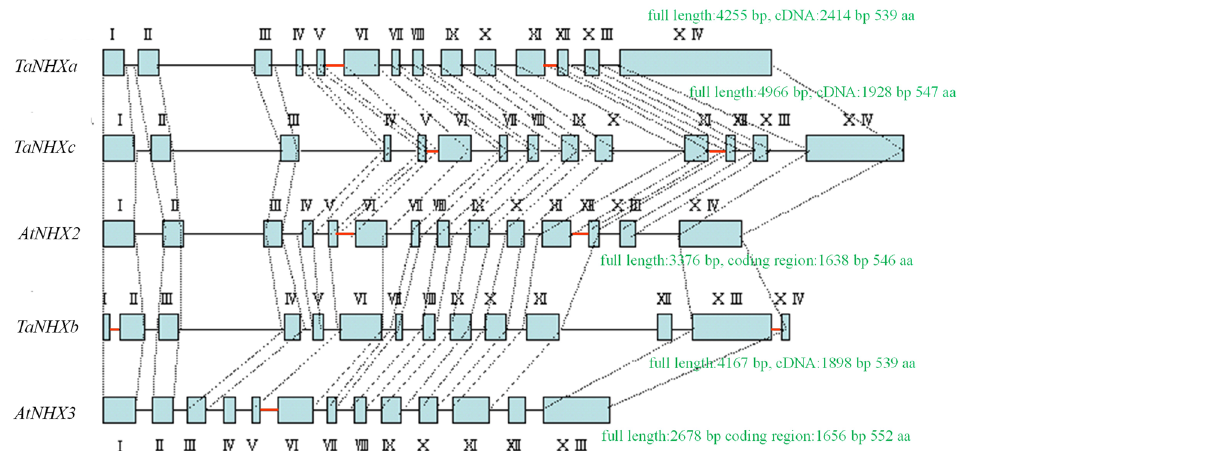
Figure 5 – Structural relationship between the wheat Na + /H + antiporter-like genes and Arabidopsis thaliana antiporter genes. The total DNA structures of TaNHXa , b and c were compared with those of AtNHX2 and 3 of Arabidopsis thaliana . TaNHXa , b and c were 22~55 % longer than AtNHX2 , and 3 in total length, 15%~17% longer in the exon, and 28%~122% longer in the intron. This reflects the enlargement of the genome size in bread wheat. TaNHXa , b , and c have 13 intron sequences; that is, one more intron than AtNHX3 . Moreover, while the nucleotide sequences of the exons showed 64%~78% homogeneity, those of the introns were as low as 54%~58%, and significant mutations were observed compared with the exons in both length and sequence. Although the positions of introns lying in the coding regions of TaNHX and AtNHX did not differ remarkably, the region corresponding